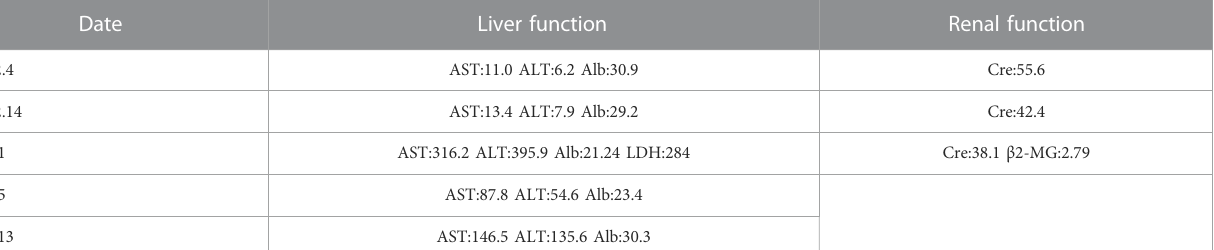
TABLE 2 Results of partial liver and renal function